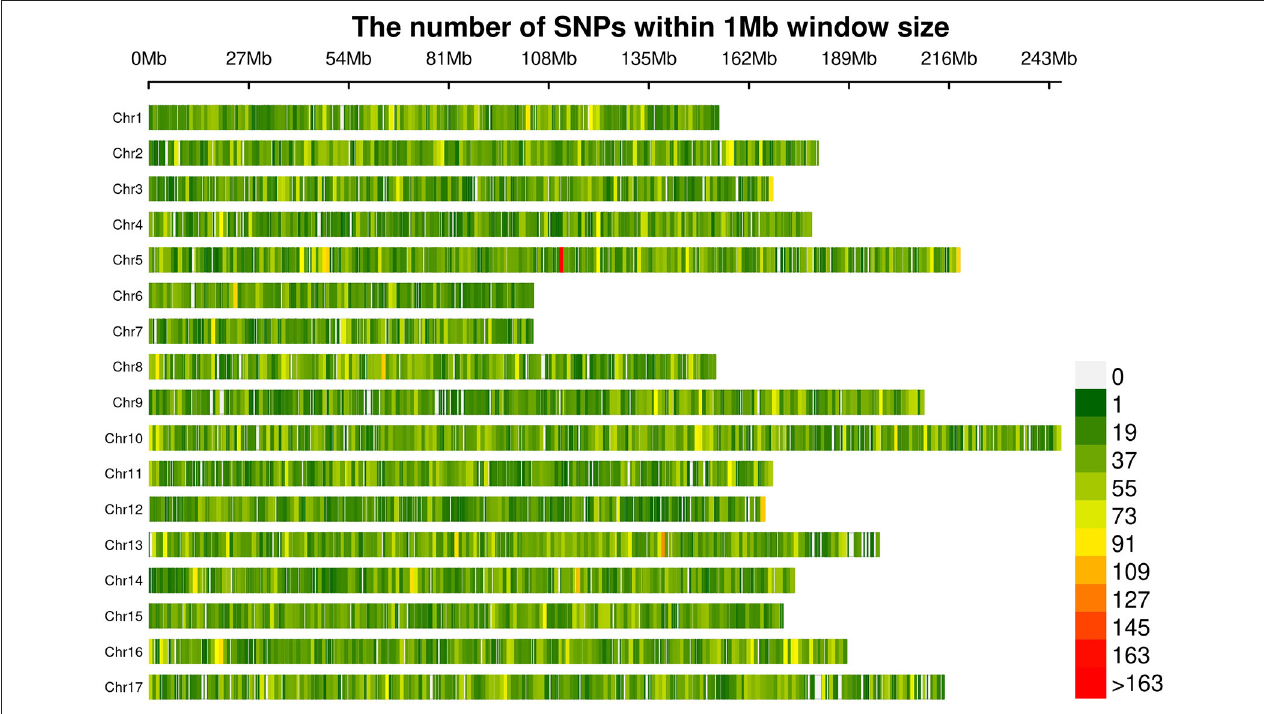
FIGURE 5 | Distribution of filtered SNPs among the 17 chromosomes. The colors indicate the number of SNPs within a 1Mb window.